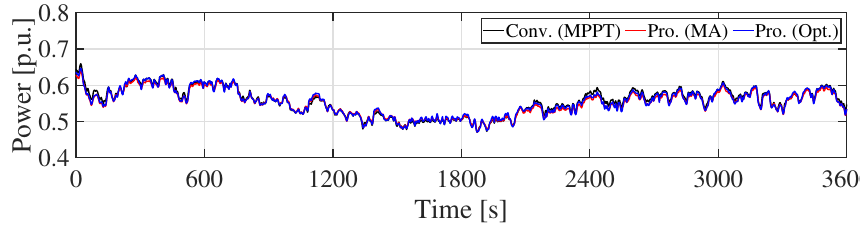
Figure 10. ESS output (Scenario 1).